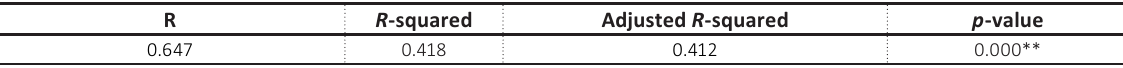
Table 16. Summary of adjusted R -squared